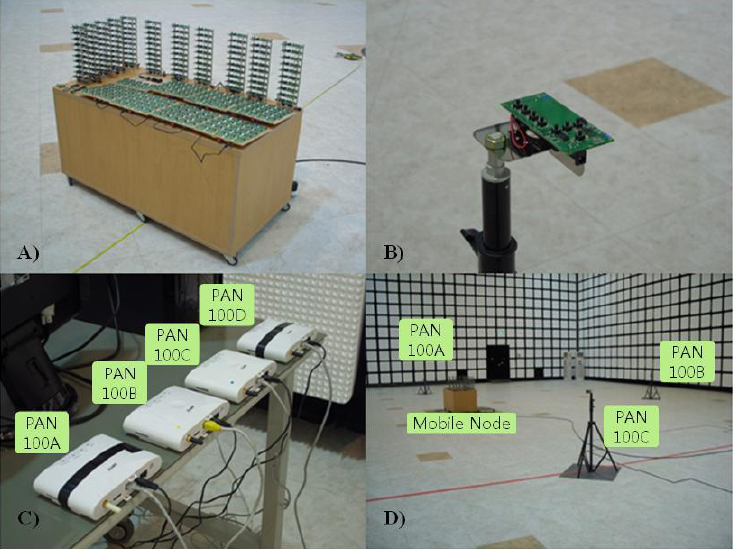
Figure 8. Test bed in the microwave anechoic chamber.